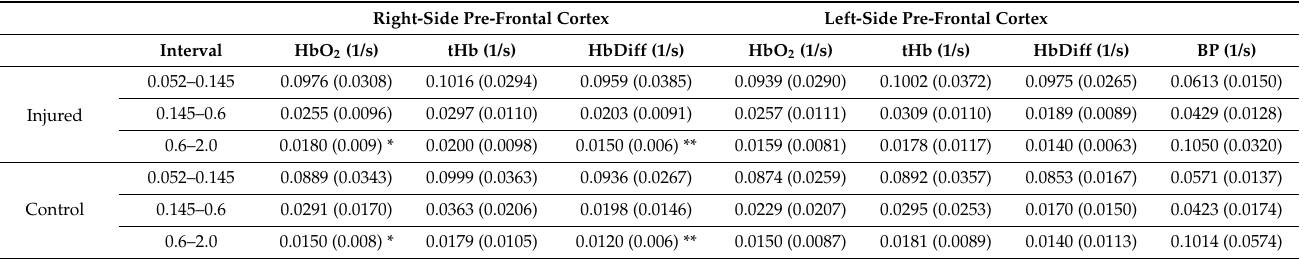
Table 1. Time-averaged wavelet transformations for the right and left pre-frontal cortex cerebral haemodynamics and blood pressure responses.